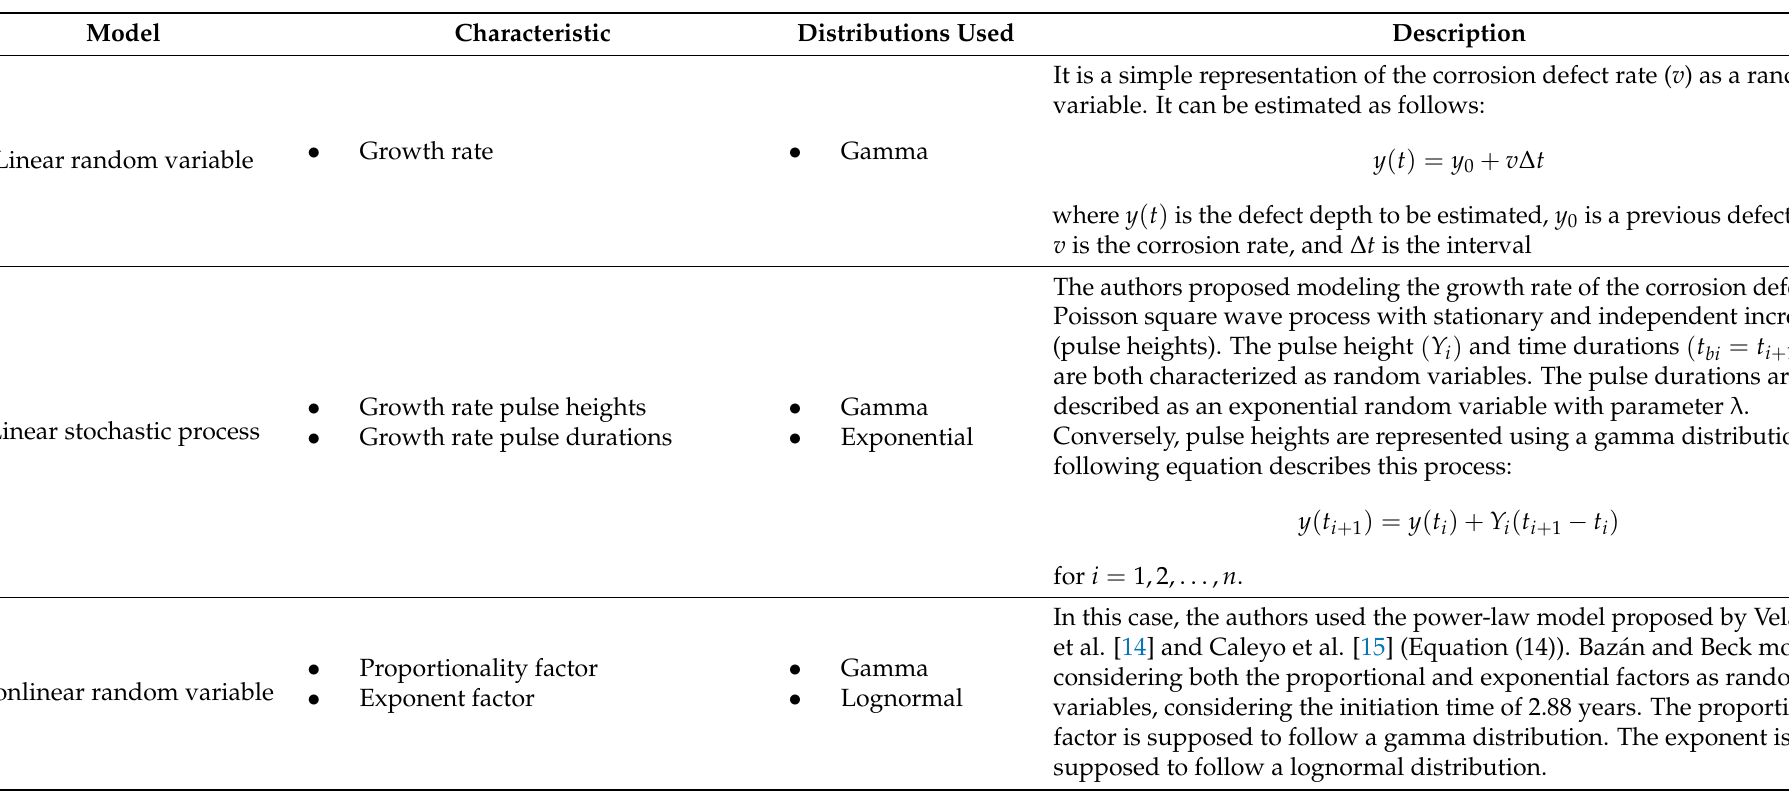
Table 1. Characteristics of the four models used by Baz á n and Beck